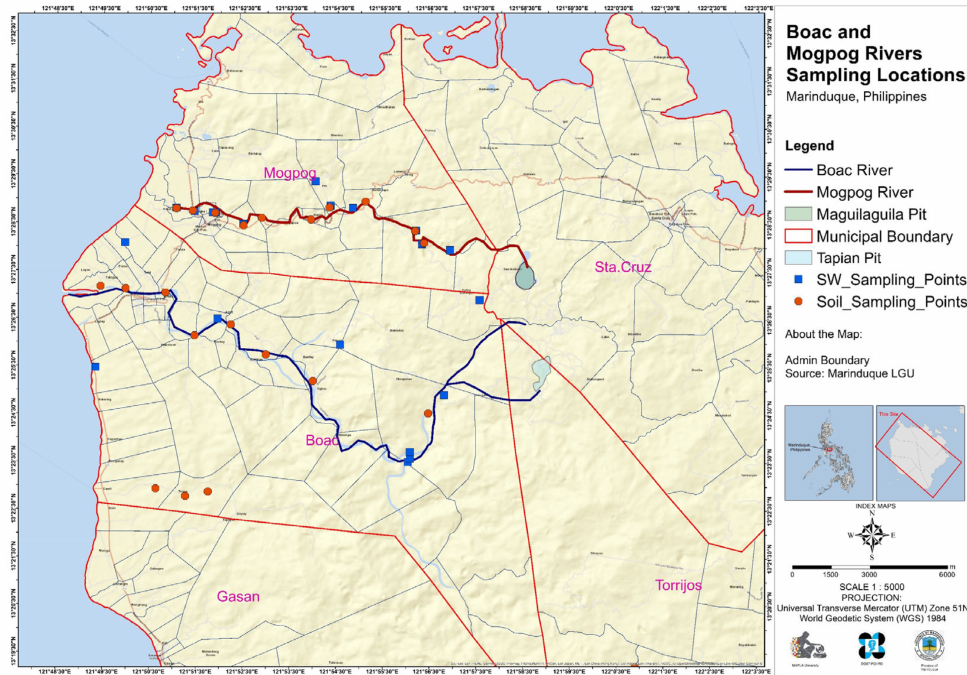
Figure 2. A map of the Philippines and Marinduque superimposed with surface water and floodplain soil sampling locations and location of Boac (red) and Mogpog (blue)